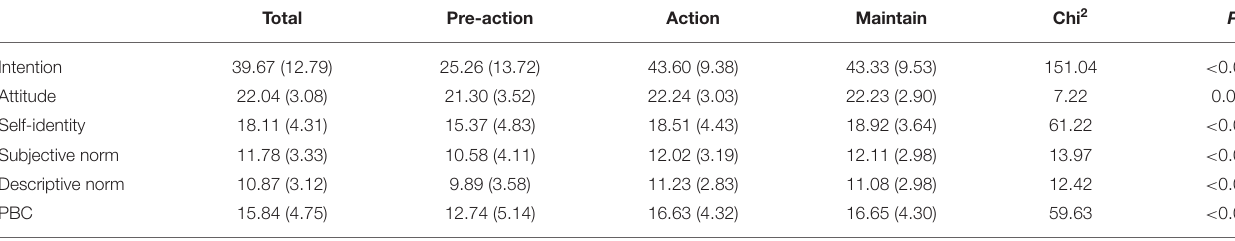
TABLE 2 | Means (standard deviations) for the extended TPB across the stages of change at baseline.